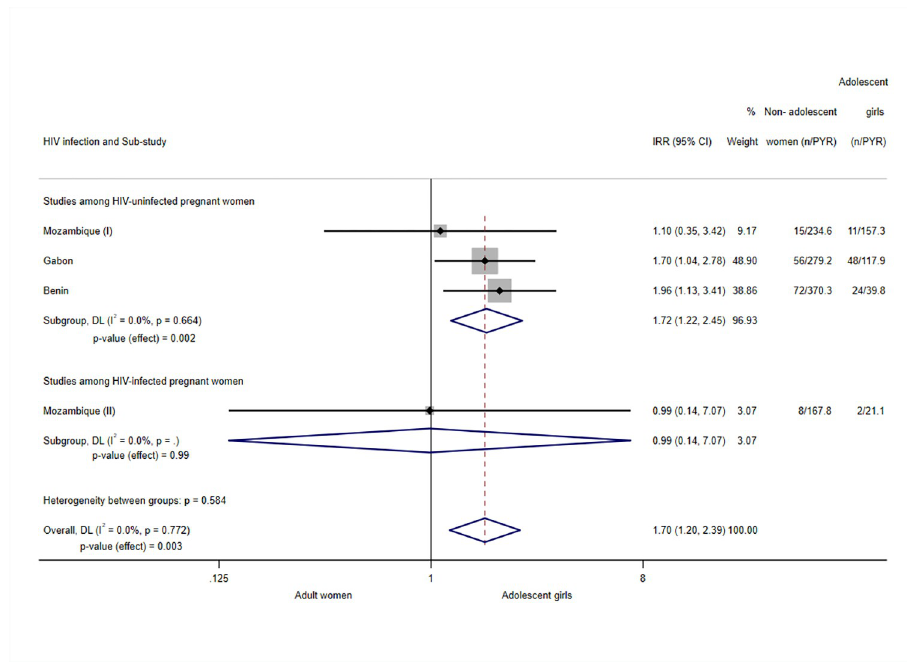
Fig 1. Analysis for clinical malaria episodes during pregnancy. Notes: Analyses adjusted by trial arm, gravidity, literacy, gestational age at recruitment, MUAC, anaemia at recruitment, adherence to the treatment (IPTp), and season at recruitment. Weights and between-subgroup heterogeneity test are from random-effects model. Tanzania (I), HIV- uninfected participants, and Tanzania (II), HIV-infected participants, were excluded from the analysis since no clinical malaria cases were reported in the study site. Kenya was excluded as well from the analysis because no clinical malaria episodes were reported among adolescent girls and no statistical adjustment could be applied to allow its inclusion. CI, confidence interval; DL, DerSimonian–Laird random effects model; IRR, incidence risk ratio; MUAC, mid-upper arm circumference; PYR, person-years at risk.